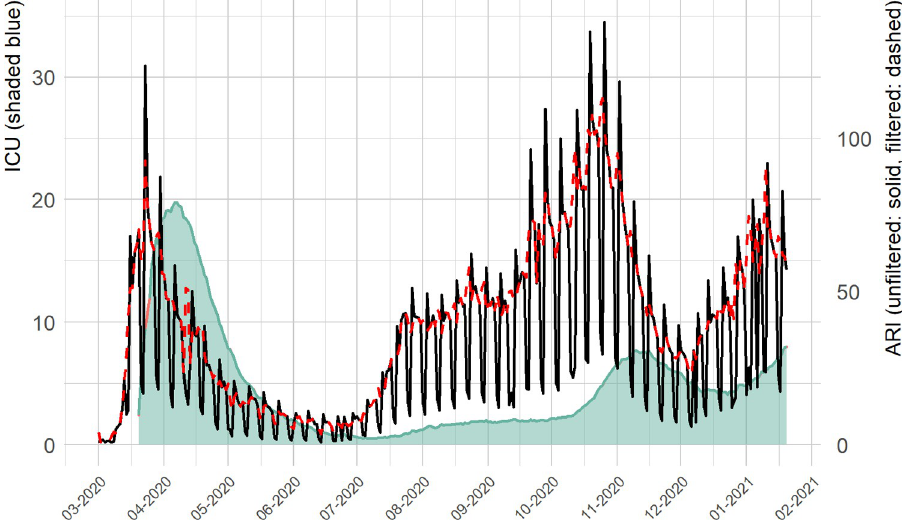
Fig 1. Daily series of acute respiratory infection rates (cases per 100,000 inhabitants, solid line), filtered series (dashed line) and ICU occupancy (beds per 100,000 inhabitants, shaded) by date (mm-yyyy).